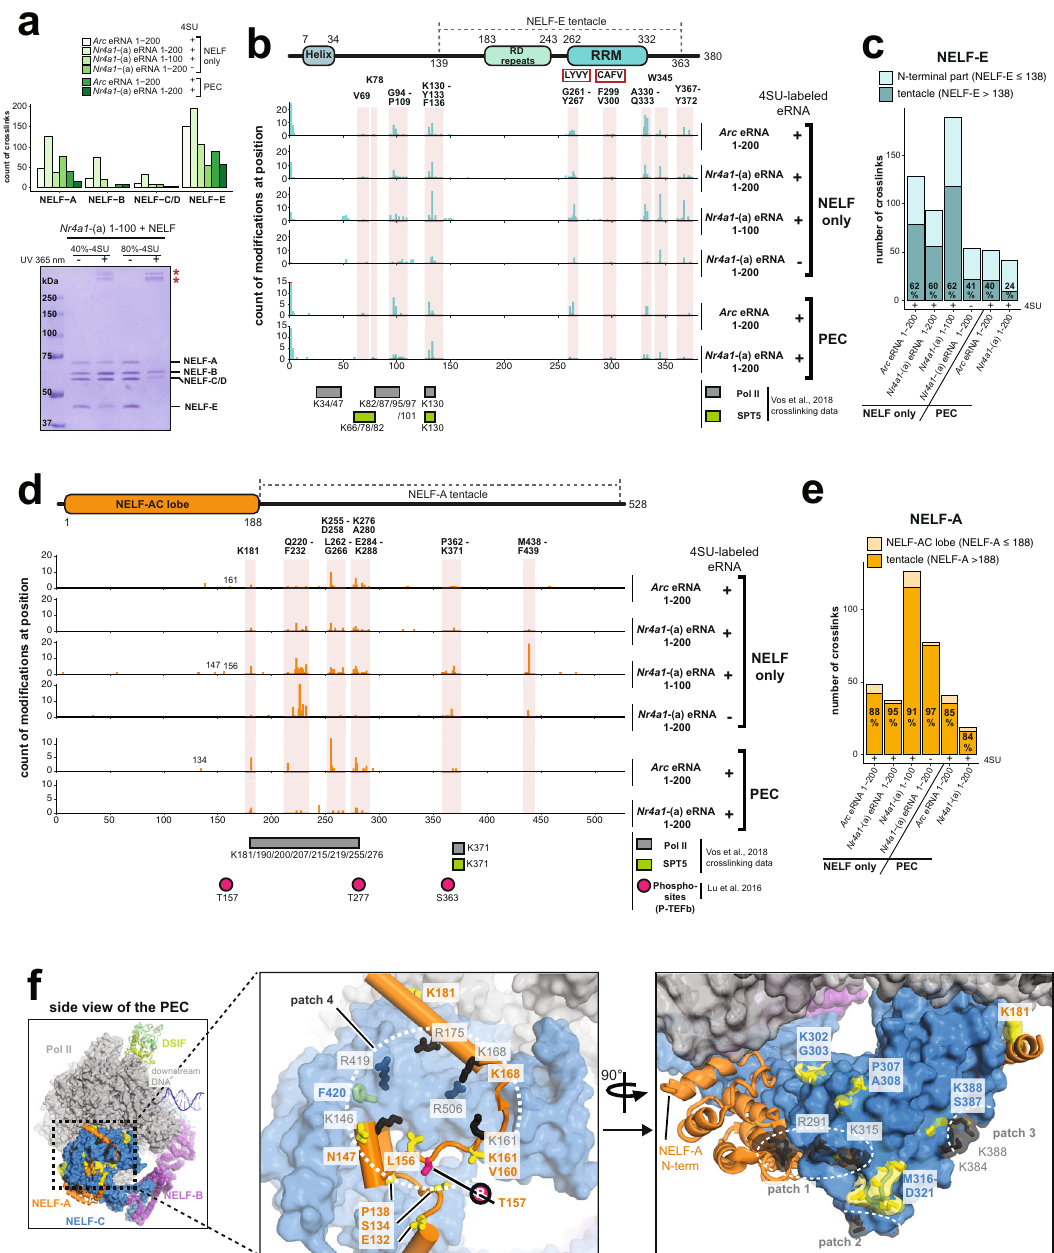
Fig. 4 eRNAs form an extensive interaction network with the N-terminal region of NELF-E and the tentacles of NELF-A and NELF-E. a The bar plot visualizes the total number of protein – RNA crosslinks (total count of nseen) to each NELF subunit for four (out of eight) eRNA crosslinking experiments to the isolated NELF complex and for two (out of two) experiments with the entire PEC (Supplementary Fig. 4a, experiments marked in red; Supplementary Data 4 – 7). Below is a 10% SDS-PAGE of two crosslinking experiments of 4SU-labeled Nr4a1 -(a) eRNAs 1 – 100, before ( − ) and after ( + ) 365 nm-induced crosslinking to the NELF complex is shown. 40% and 80%-4SU denote the concentration of 4-thiouridine vs. uridine during in vitro transcription (Supplementary Fig. 4a, Methods). Upon crosslinking predominantly NELF-E and NELF-A disappears while high-molecular bands corresponding to crosslinked protein – RNA products appear (marked by red asterisks). b Total number of nucleotide-crosslinks at each amino acid (aa) position plotted along the NELF-E sequence (1 – 380 aa). Data were shown for the same samples as in ( a ). The crosslinking results for all eight experiments are shown in Supplementary Fig. 5. Clusters of crosslinks or single crosslinking positions that are present throughout all samples are highlighted. Representative amino acid residues are indicated above the highlighted boxes. The domain architecture of NELF-E is schematically displayed on top. c Distribution of all crosslinks plotted in ( b ) between the N-terminal portion of NELF-E and the NELF-E tentacle. d Nucleotide-crosslinks to NELF-A plotted as in ( b ). e Distribution of all crosslinks plotted in ( d ) between the NELF-AC lobe and the NELF-A tentacle. f Nucleotide-crosslinks to the NELF-AC lobe mapped onto the PEC (PDB code 6GML) displayed in the left panel. Crosslinked residues in the vicinity of the positively charged patches 4 (middle panel) and 1 – 3 (right panel) are displayed as sticks and colored in yellow. The referring amino acid is reported next to the structure and in the color of the corresponding NELF subunit (NELF-A = orange; NELF-C = blue). Lysine and arginine residues associated with the positively charged patches 42 are also shown as sticks and colored in black. T157 is highlighted in pink and marked with an encircled P. Source data for ( a , c , e ) are provided in a Source Data fi le. Data shown in ( b , d ) are part of Supplementary Data 4,